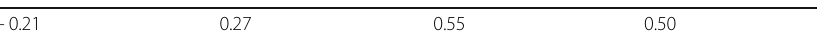
Table 13 Co-movement of the HP output gap between Greece and OECD t − 2 t − 1 t t + 1 t + 2 − 0.21 0.27